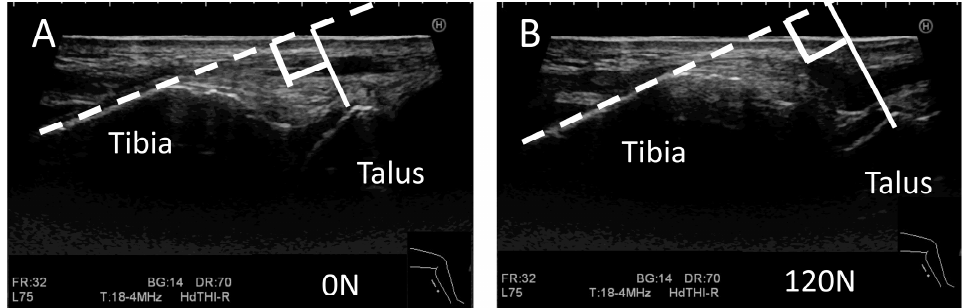
Figure 3. Measurement of the distance between the tibia and talus during the ultrasound stress imaging test. Images from the ultrasound stress imaging test at 0 N ( A ) and 120 N ( B ). The white solid line represents the distance between the tibia and medial tubercle of the posterior process of the talus, and the white broken line represents an extension of the border of the cortical bone of the posterior tibia manually set by the rater.